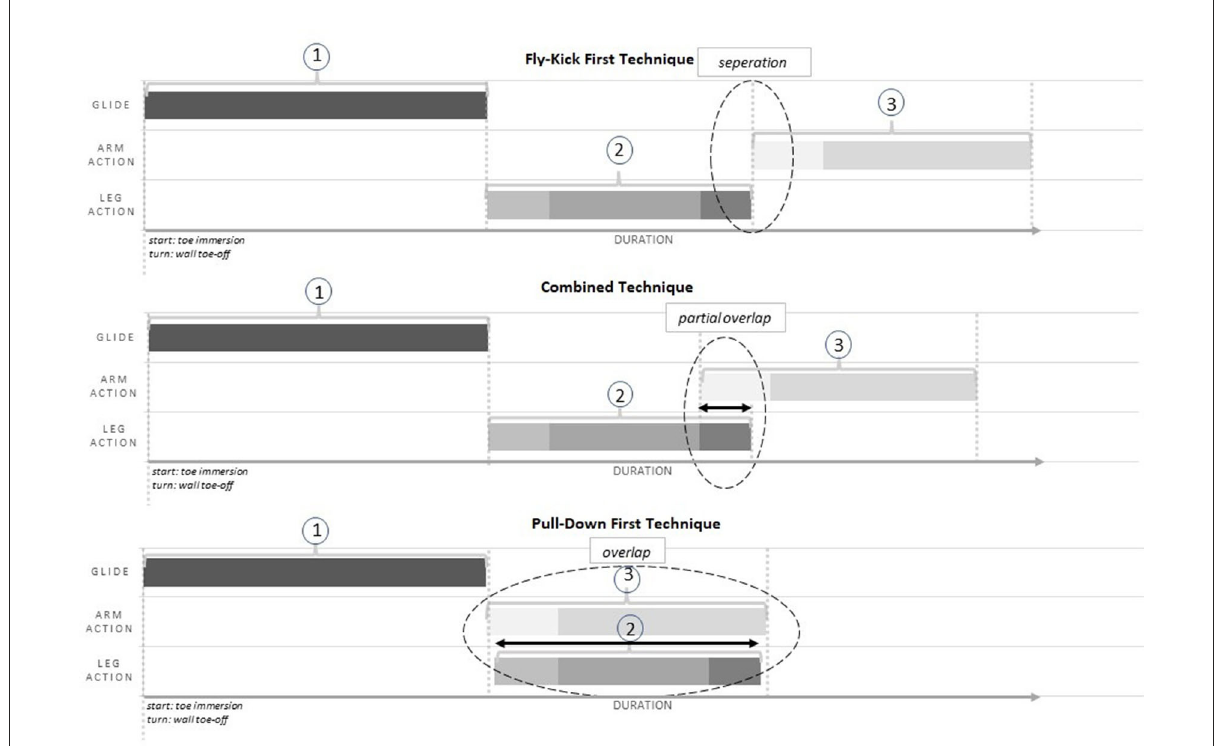
FIGURE3 Breaststroke pullout phase profile variations; indicating the primary difference in arm and leg action sequence across the Fly-Kick First, the Combined and the Pull-Down First techniques. The numbers 1, 2, and 3 represent the first three phases of the pullout [1st Glide, Dolphin Kick, and Pull Down phase].